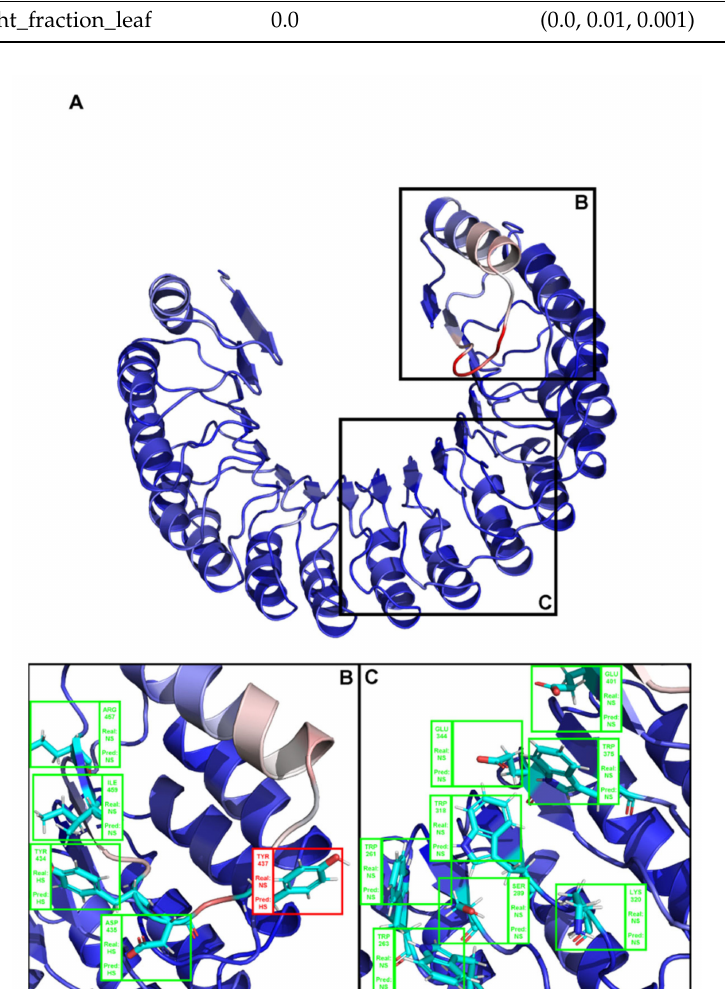
Figure A1. ( A ) Structural representation of the complex between angiogenin and a ribonuclease inhibitor: PDB ID 1a4y. Brighter red colors were attributed to residues with a higher probability of being classified as HS. ( B , C ) Close-ins of all interfacial residues for which there is an experimental ∆∆ G binding value, and as such a HS / NS classification. Green boxes represent correctly predicted residues, whereas red boxes represent incorrectly classified